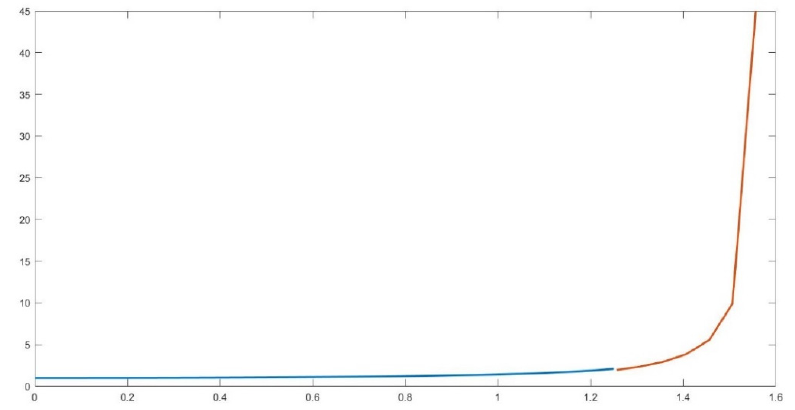
Figure 4. Depiction of Cabeza ‐ Lainez coefficient κ (blue) and limit case (red). For lower quantities, the coefficient performs smoothly, since cos θ tends to be one and the same as κ does, so our prediction becomes even more